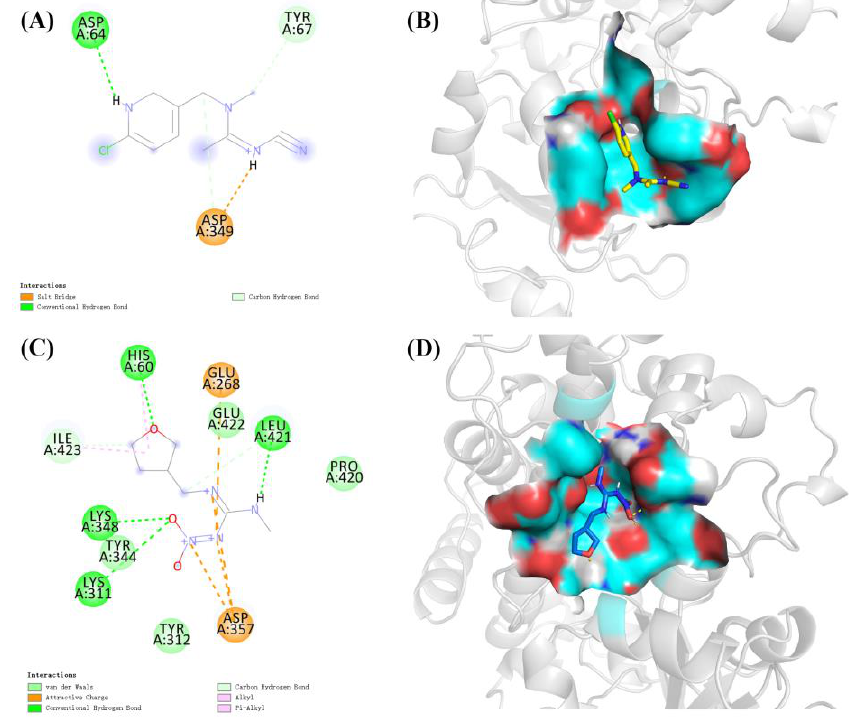
Figure 6. Binding pattern of CYP6ER1 with insecticide molecules. ( A ) the 2D ligand interaction between CYP6ER1 and acetamiprid and ( B ) its binding pocket; ( C ) the 2D ligand interaction between CYP6ER1 and dinotefuran and ( D ) its binding pocket.